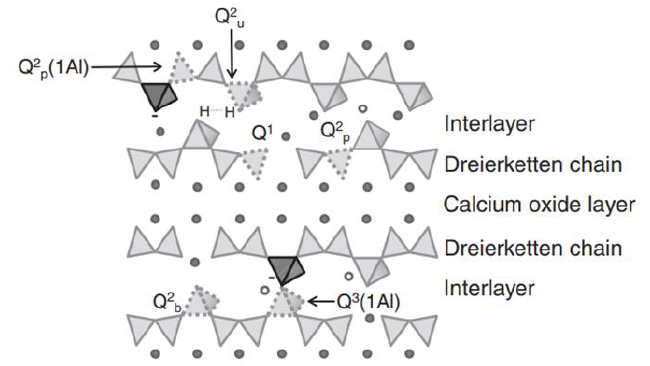
Figure 4. Schematic structure of calcium-aluminosilicate-hydrates (C-A-S-H). Interlayer includes calcium ion, water, alkali, or negative charge; dreierketten chain includes SiO 4– and AlO 4- ; Q n (mAl) indicates the number of adjacent Si and Al; b and p indicate the bridging position and pairing position, respectively [53,54].